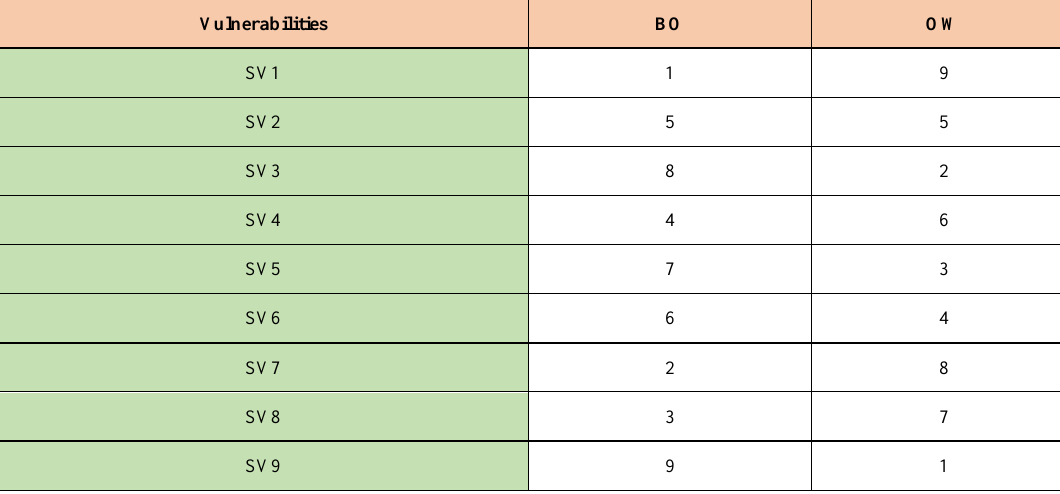
Table 4. Best-to-Others (BO) and Others-to-Worst (OW) pair-wise comparison